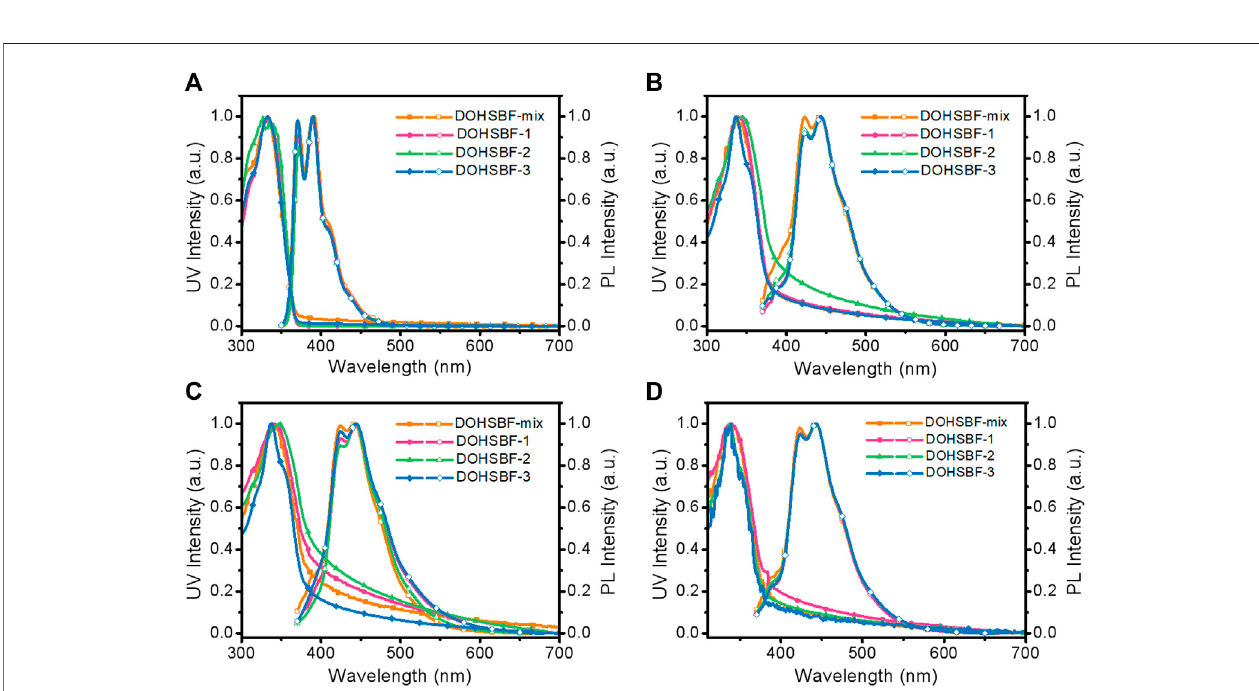
FIGURE 4 | Optical properties of DOHSBF in various states. UV-vis absorption and photoluminescence (PL) spectra of DOHSBF (A) dilute solutions, (B) spin- coated pristine fi lms, (C) annealed fi lms at 220 ° C for 10 min, and (D) photooxidation fi lms, respectively.